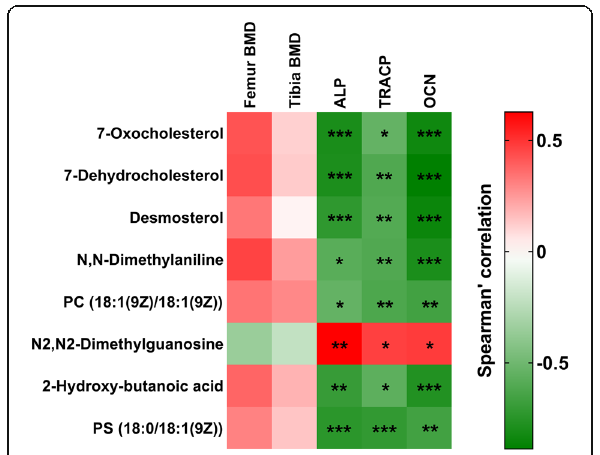
Fig. 8 Correlation between differential metabolites and BMD or bone metabolism index. Different colors (green to red) represent correlation coefficients. * P <0.05, ** P <0.01, *** P <0.001. BMD, bone mineral density. ALP, alkaline phosphatase. OCN, osteocalcin. TRACP, tartrate resistant acid phosphatase